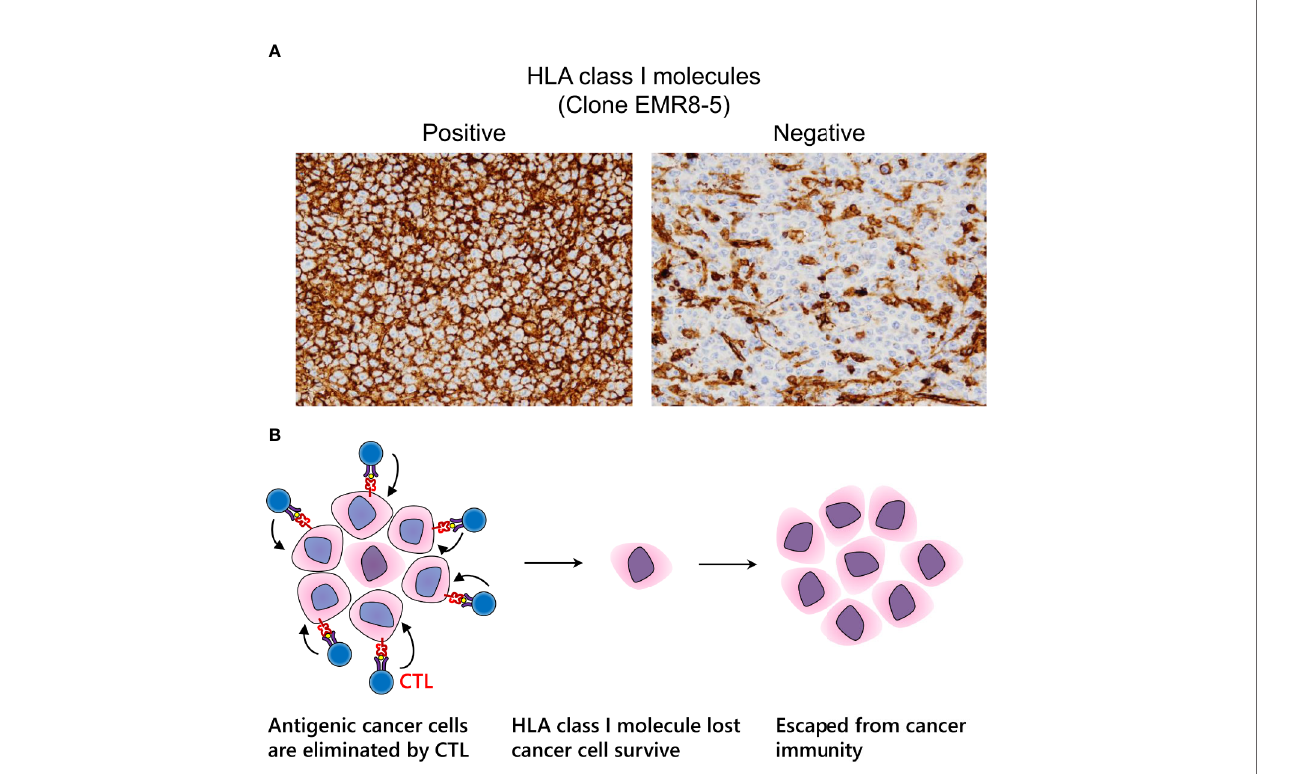
FIGURE 5 | Immune escape via loss of human leukocyte antigen (HLA) class I molecules. (A) Expression pattern of HLA class I molecules detected by the EMR8-5 monoclonal antibody in diffuse large B cell lymphoma. Left: intact cell boundary staining; Right: loss of staining. (B) Adaptive immune escape hypothesis: immunogenic tumor cells are eliminated by cytotoxic T lymphocytes; nevertheless, tumor cells without HLA class I molecules survive and